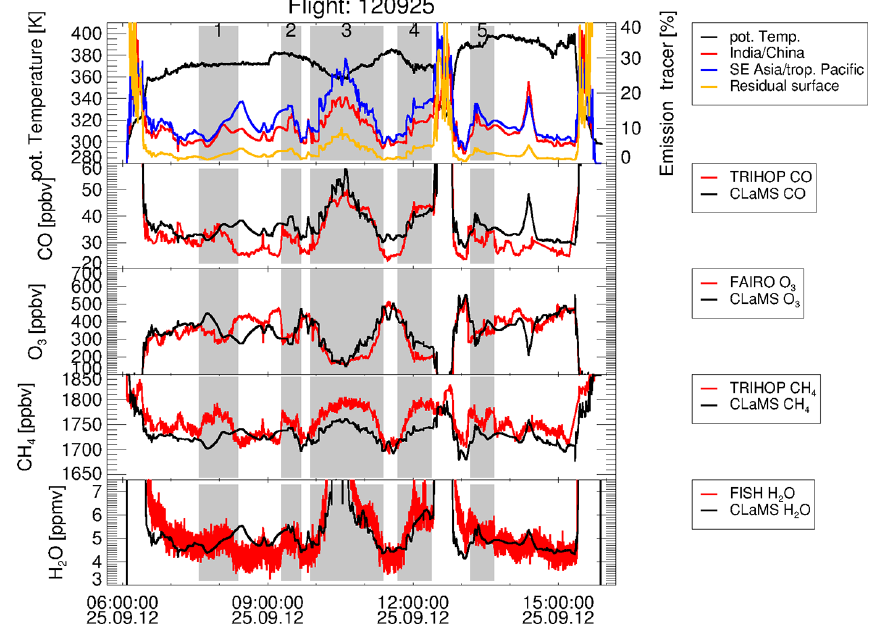
Figure 10. The same as Fig. 9, but for the flight on 25 September 2012.